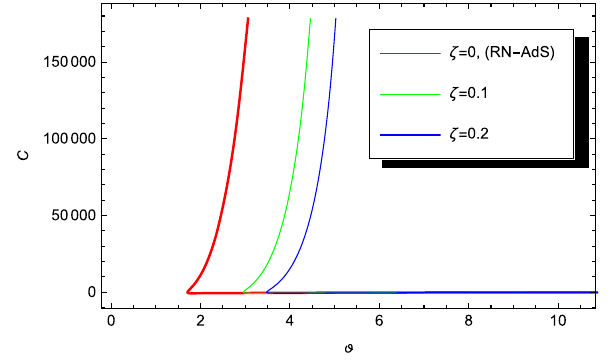
Fig. 17 Plot of the heat capacity C w.r.t ϑ for Q = 0 .